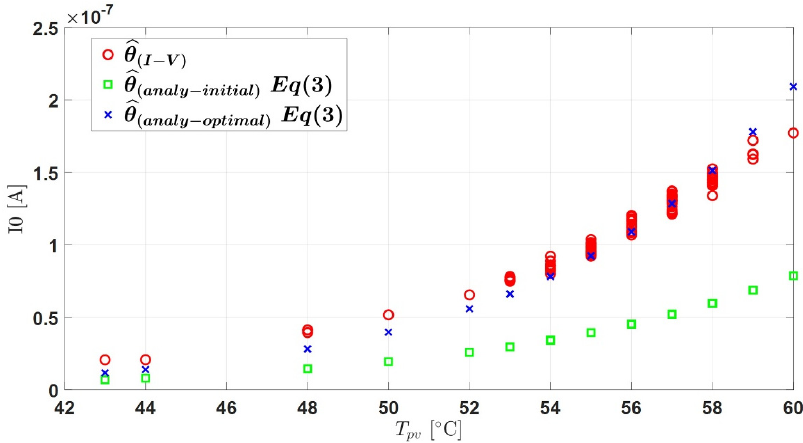
Figure 14 . Evolution of the diode saturation current ( 𝐼 (cid:2868) ).